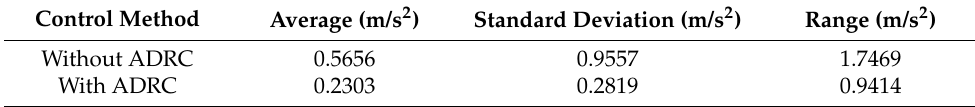
Table 2. Speed error statistics of the host vehicle with 200 kg load and 5 ◦